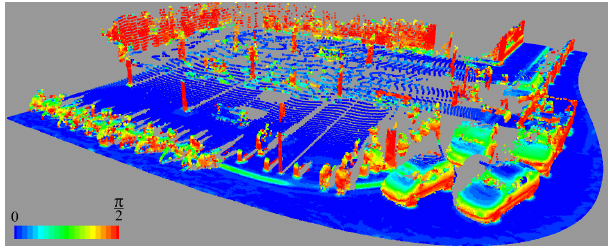
Figure 2: The θ feature map. blue area in Fig. 1) where all points are taken into account to fit a plane (least-square fitting). The normal V p at p is computed, and θ is the difference of angle with z the normal to the